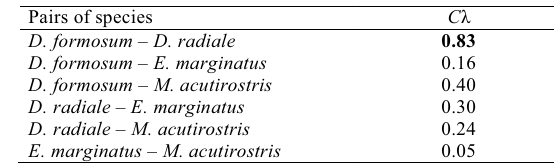
Table 4. Food overlap ( C (cid:79) ) between each pair of the studied species (significant value is in bold type, when C (cid:79)(cid:116) 0.6). Pairs of species C (cid:540) D. formosum – D.